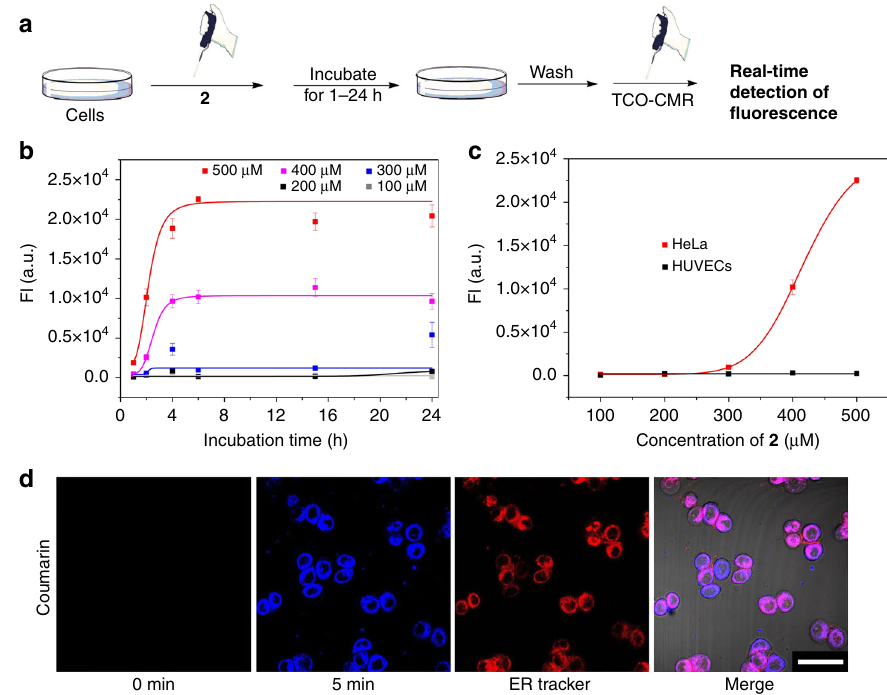
Fig. 3 Quanti fi cation and location of the intracellular self-assembly in live cells. a Flowchart showing the cell culture conditions. Each group of cells was treated with different concentrations (100 – 500 μ M) of 2 for a range of durations (1, 2, 4, 6, 15 and 24 h), washed with PBS and incubated with 100 μ L of 50 μ M TCO-CMR. b Fluorescence intensity of restored coumarin in HeLa cells for each incubation condition with 100 – 500 μ M 2 for 1, 2, 4, 6, 15 and 24 h, respectively ( n = 6). c Comparison of the fl uorescence intensity from restored coumarin in HeLa cells and HUVECs. All cells were pre-treated with 100 – 500 μ M 2 for 6 h, washed with PBS and incubated with 100 μ L of 50 μ M TCO-CMR for 24 h ( n = 6). Error bars indicate standard deviation. d Confocal images showing the distribution of liberated coumarin (blue) and the overlap with ER tracker (red). Scale bar, 50 μ